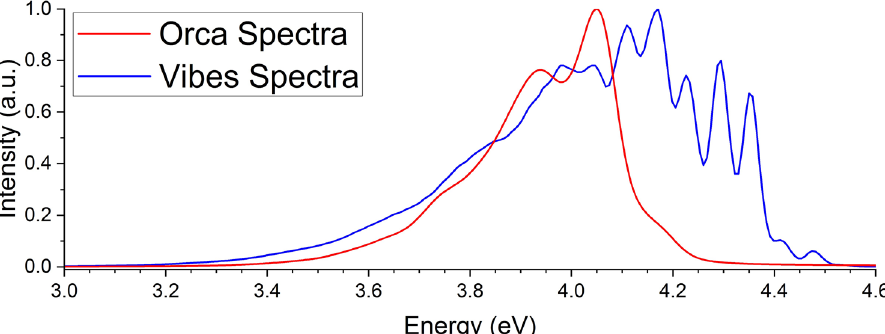
Figure 4. Calculated second-order corrected emission spectra using Orca (red). Reference second-order corrected emission spectra taken from Fig. 3A (blue). Spectra are normalised by intensity, and as such are not to